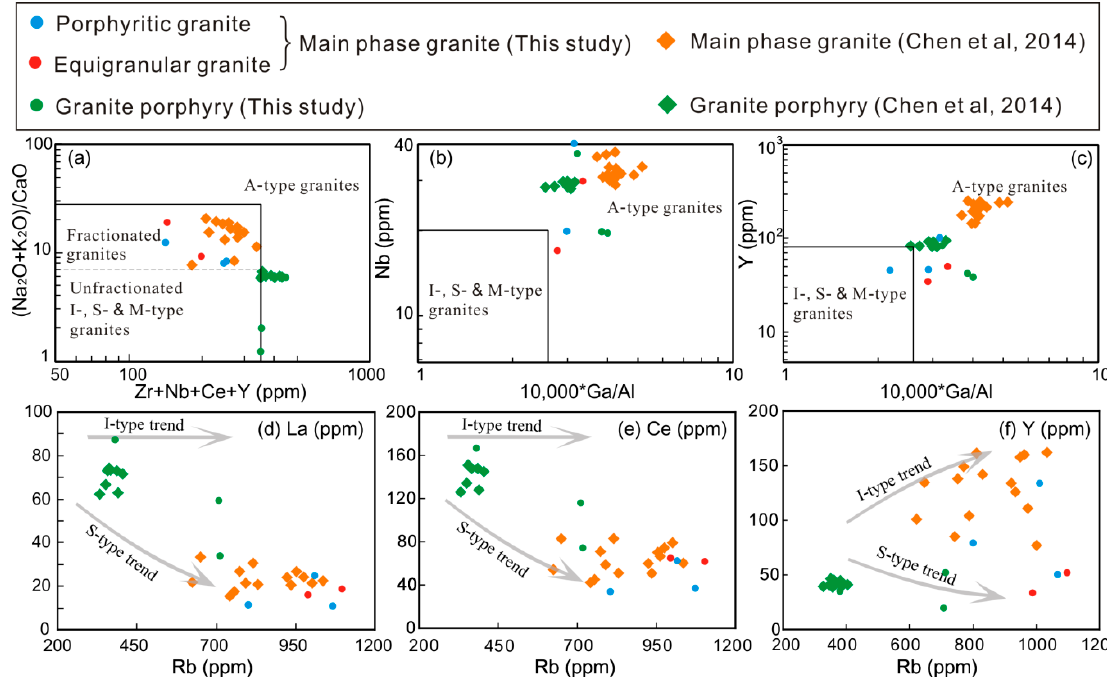
Figure 9. Selected plots of trace element concentrations from I-, S-, and A-type granitoids: ( a ) (Na 2 O + K / CaO vs. Zr + Nb + Ce + Y, ( b ) Nb vs. 10,000*Ga / Al, and ( c ) Y vs. 10,000*Ga / Al + K 2 O)/CaO vs. Zr + Nb + Ce + Y, ( b ) Nb vs. 10,000*Ga/Al, and ( c ) Y vs. 10,000*Ga/Al classification 2 O)